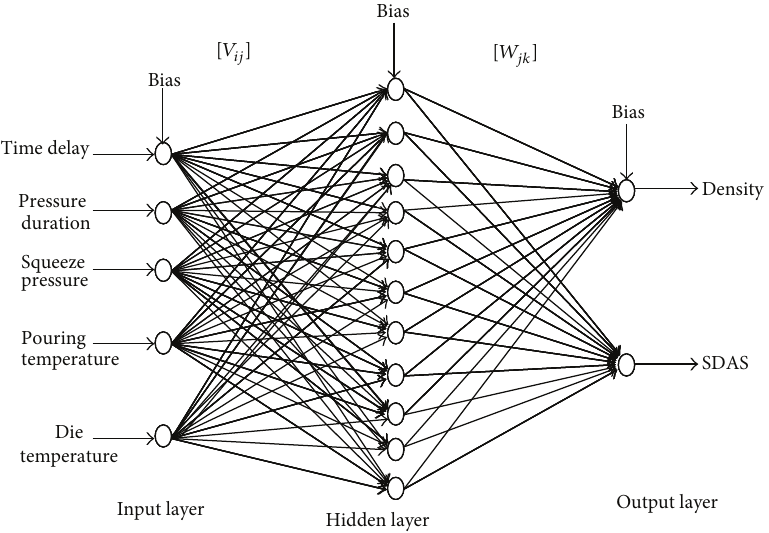
Figure 2: Artificial neural network architecture used for forward